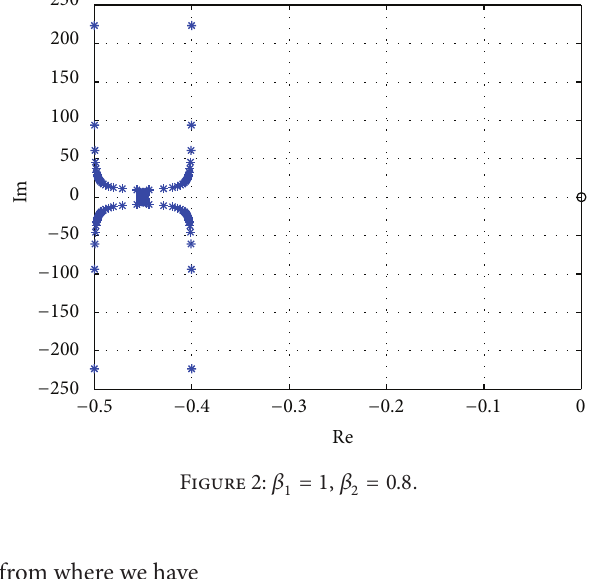
Figure 2: 𝛽 1 = 1 , 𝛽 2 = 0.8